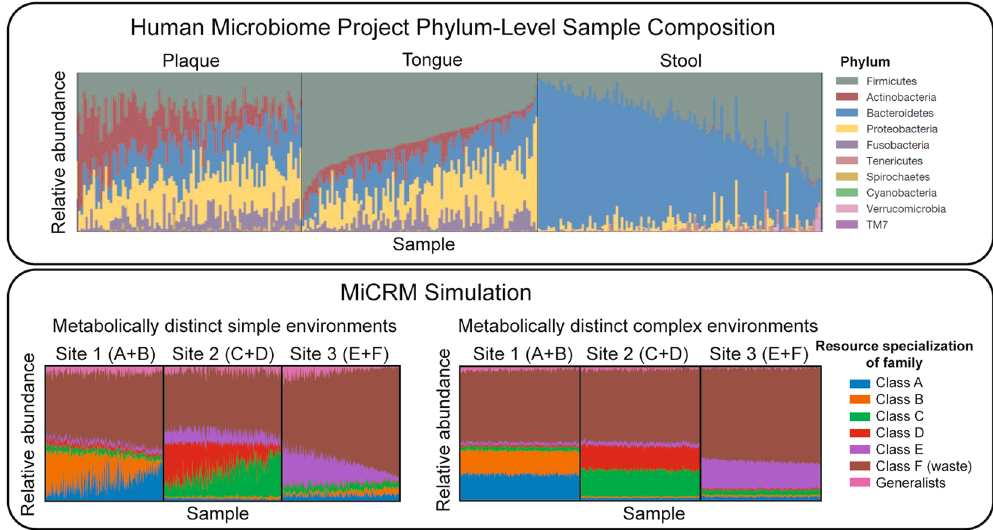
Figure 6. Low-dimensional nutrient supply variation reproduces patterns in human microbiome survey data. Top: Each column represents one sample from the Human Microbiome Project (HMP). Colored segments represent relative abundances of different phyla in each community. Reproduced from Figure 2 of the initial open-access report on the results of the HMP 2 . Bottom: Each column represents one of 900 simulated samples, each stochastically colonized with 2,500 species from a regional pool of 5,000 species, comprising seven metabolically distinct families. Colored segments represent relative abundances of the seven families defined in Fig. 4. Each of the three “body sites” was supplied with resources from a different pair of resource classes, with total nutrient supply fixed. In the first set of simulations (left), one resource from each class was supplied, and the ratio of the two supply rates was randomly varied from sample to sample. In the second set (right), all resources from each class were supplied, with randomly chosen supply rates for each sample, normalized to keep the total supply fixed. The brown family present in all three environments specializes in the typical byproducts (e.g., carboxylic acids) generated from all the other resource classes. Within each body site, samples are sorted by relative abundance of this family. See main text and Methods for simulation